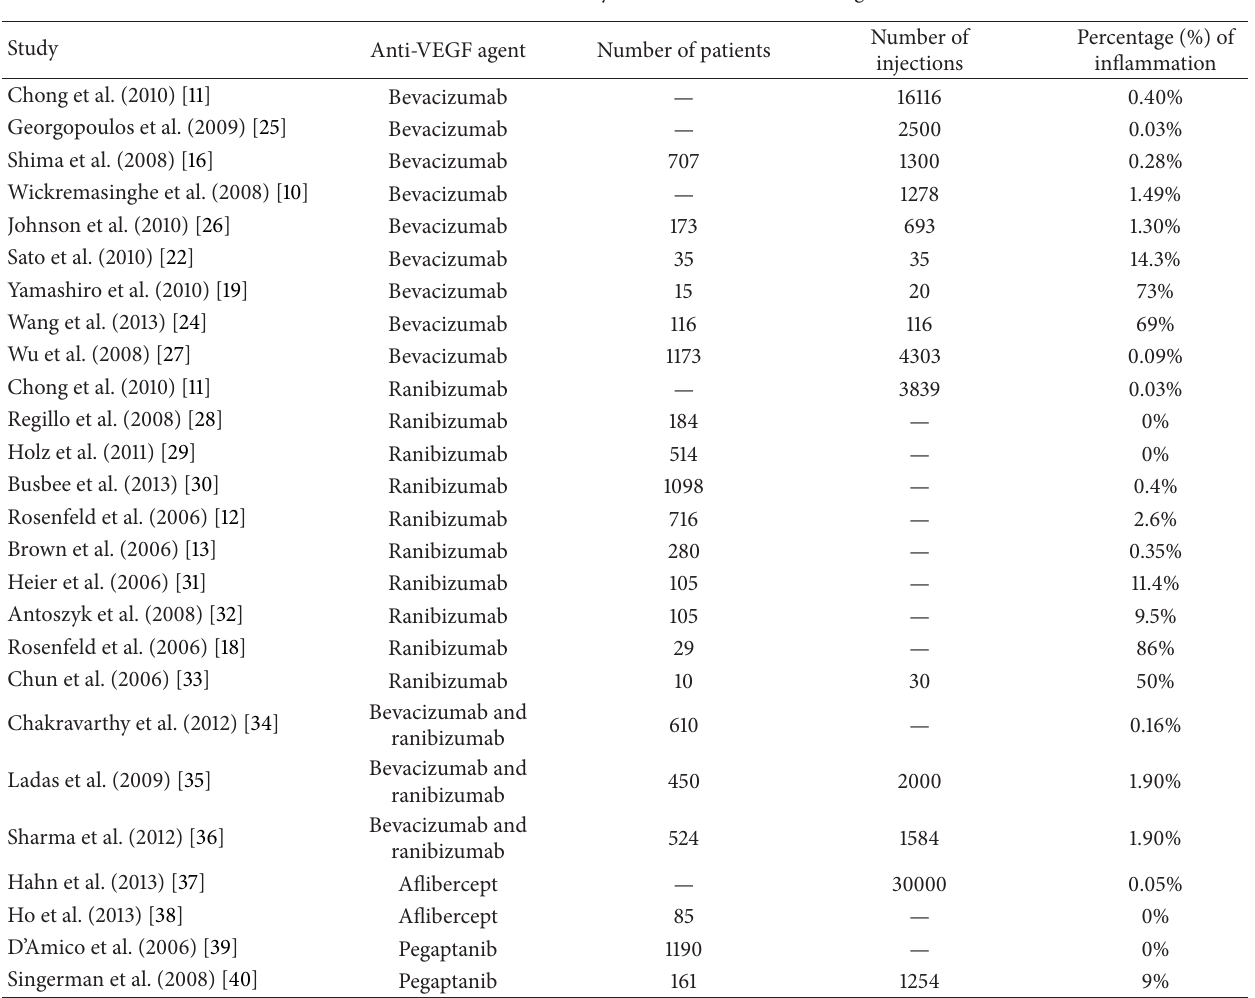
Table 2: Sterile inflammatory rates between anti-VEGF